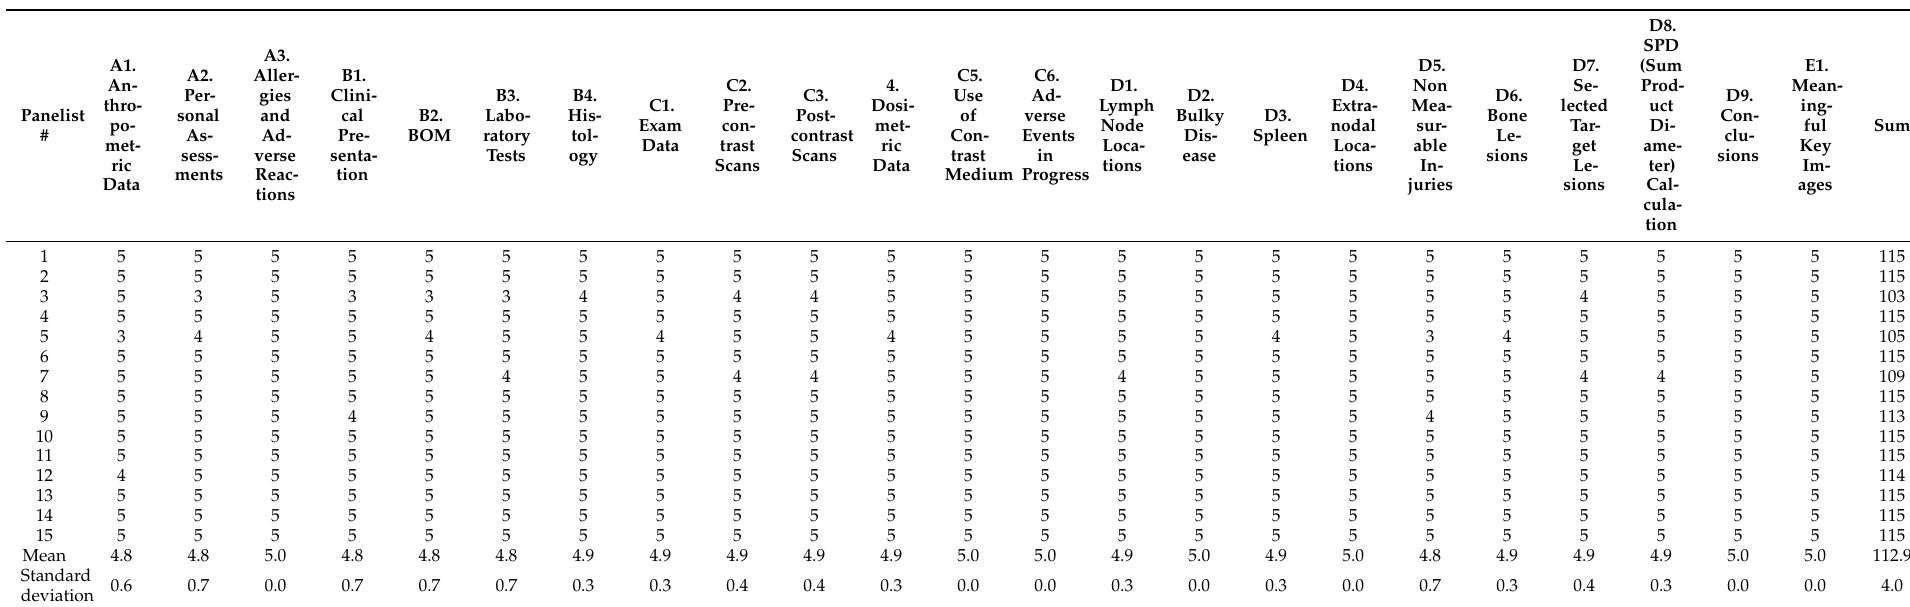
Table 2. Single scores and sum of scores of 15 panelists for structured report in the second Delphi